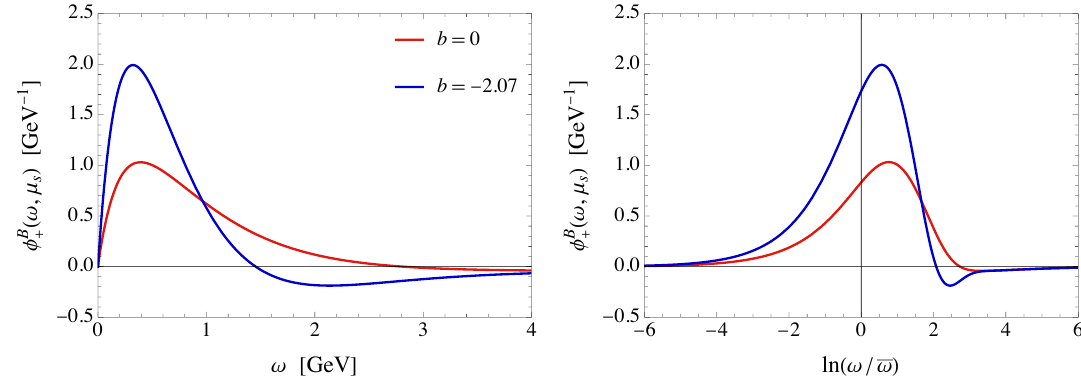
Figure 2 . Left: the two model functions for the LCDA φ B ( ω, µ s ) at the low scale µ s = 1 GeV, + obtained with b = 0 , ¯ ω = 183 MeV (red curve) and b = − 2 . 07 , ¯ ω = 141 MeV (blue curve). In both cases we set ω 0 = 482 MeV. The parameters are chosen such that λ B ( µ s ) = 350 MeV and 200 MeV, respectively, whereas σ B ( µ s ) = 0 in both cases. Right: the two model LCDAs as functions of the 1 variable ln( ω/ ¯ ω ) . The area under the curves corresponds to the parameter 1 /λ B ( µ s ) , while in each case the parameter ¯ ω is chosen such that the functions are centered at